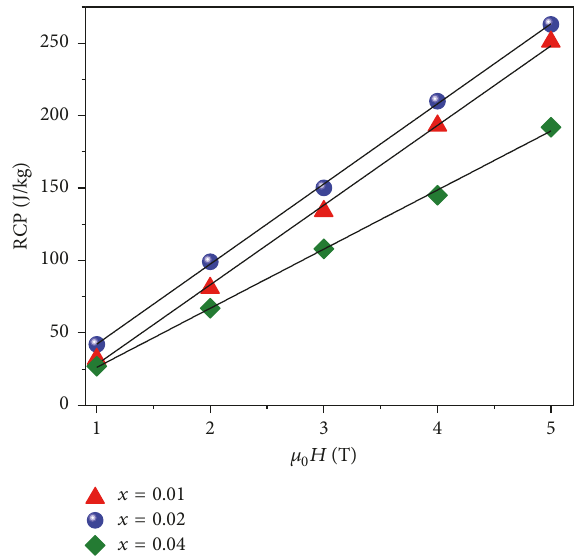
Figure 7: Field dependence of the RCP for MnCo 1−𝑥 Zr 𝑥